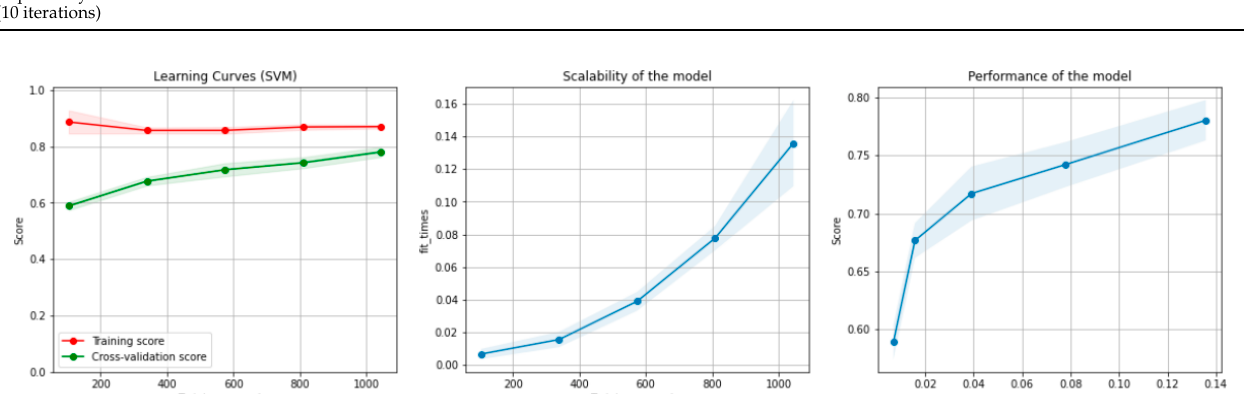
Figure 6. Learning curves, model scalability and model performance for the SVM algorithm, for the non-overlapping dataset.